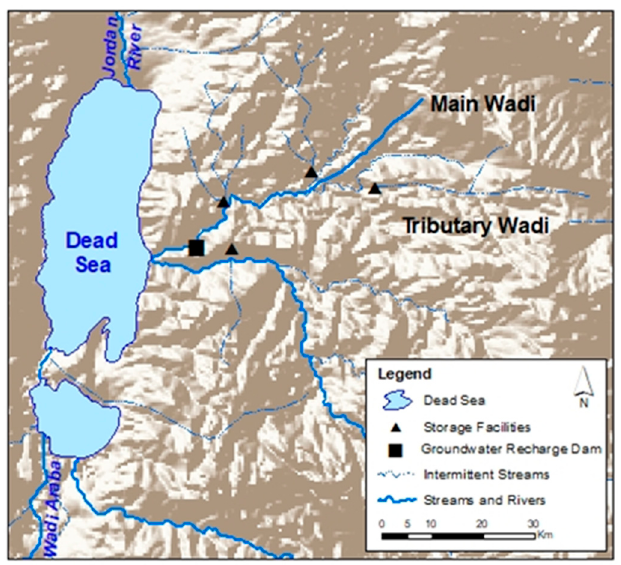
Figure 6. Along the main wadis discharging into the Jordan Valley and Wadi Araba groundwater recharge schemes are of high potential at the foot hills, where the main side wadis enter the Jordan Rift Valley. In the upstream areas, surface water storage has high potential, with some bank storage around the surface water reservoir. Owing to the effluent nature of the groundwater, along the upper reaches of these wadis groundwater recharge is not feasible.